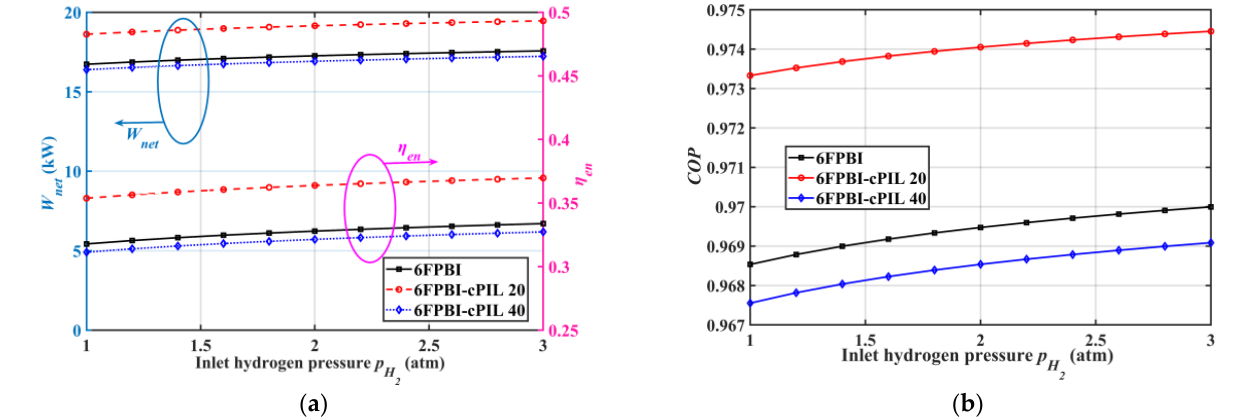
Figure 5. Variation of system performance with inlet hydrogen pressure: ( a ) output power W net and energy efficiency η en ; ( b ) the coefficient of performance COP .